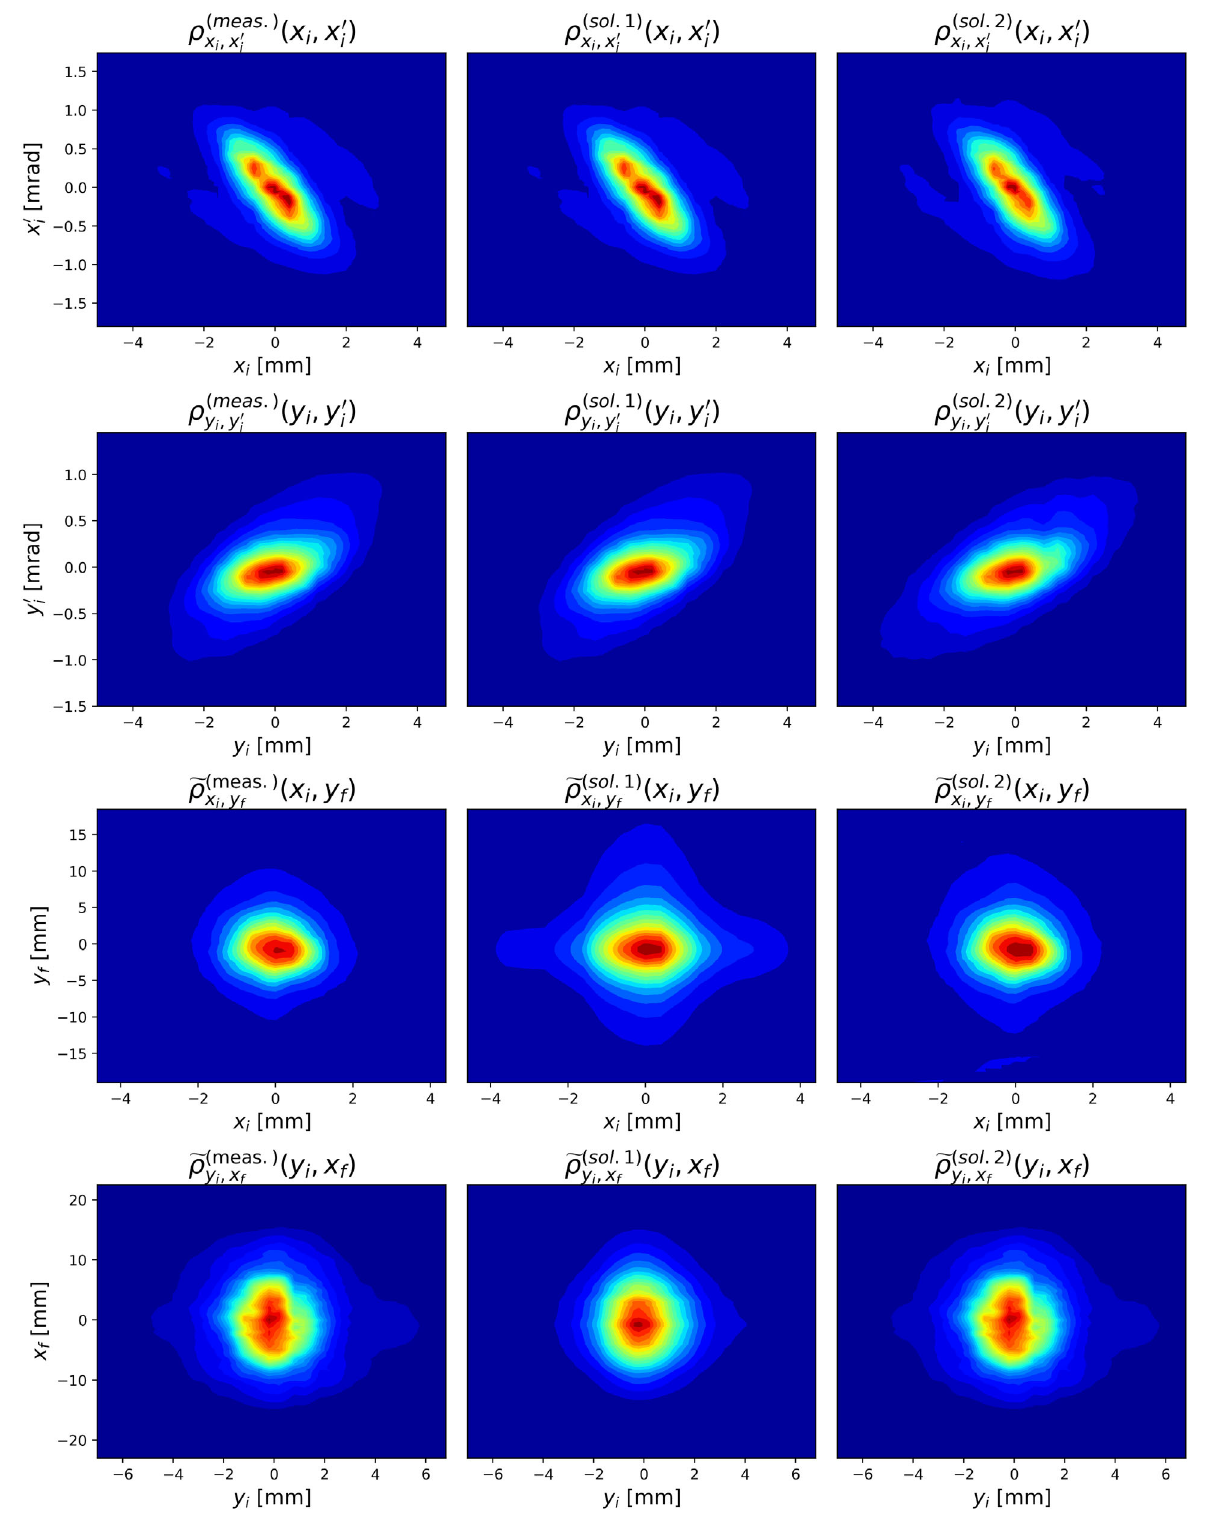
FIG. 2. Four 2D scan results at the SNS HEBT laser wire station (left column, denoted by superscript “ meas ” ) compared against the corresponding 2D projections of two 4D distributions (middle and right columns) that are tomographically reconstructed based on these scan results. Among the two reconstructed 4D distributions, the superscript “ sol 1 ” denotes the two-scan analytical MENT solution that only uses the two conventional scans with parallel wires, whereas “ sol 2 ” denotes the four-scan numerical MENT solution obtained using all four 2D